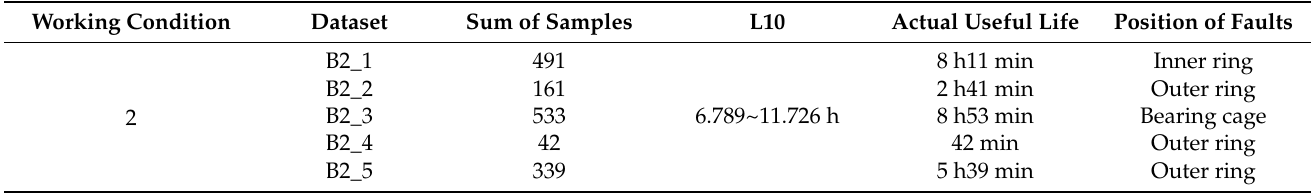
Table 3. XJTU-SY datasets of bearings under working condition